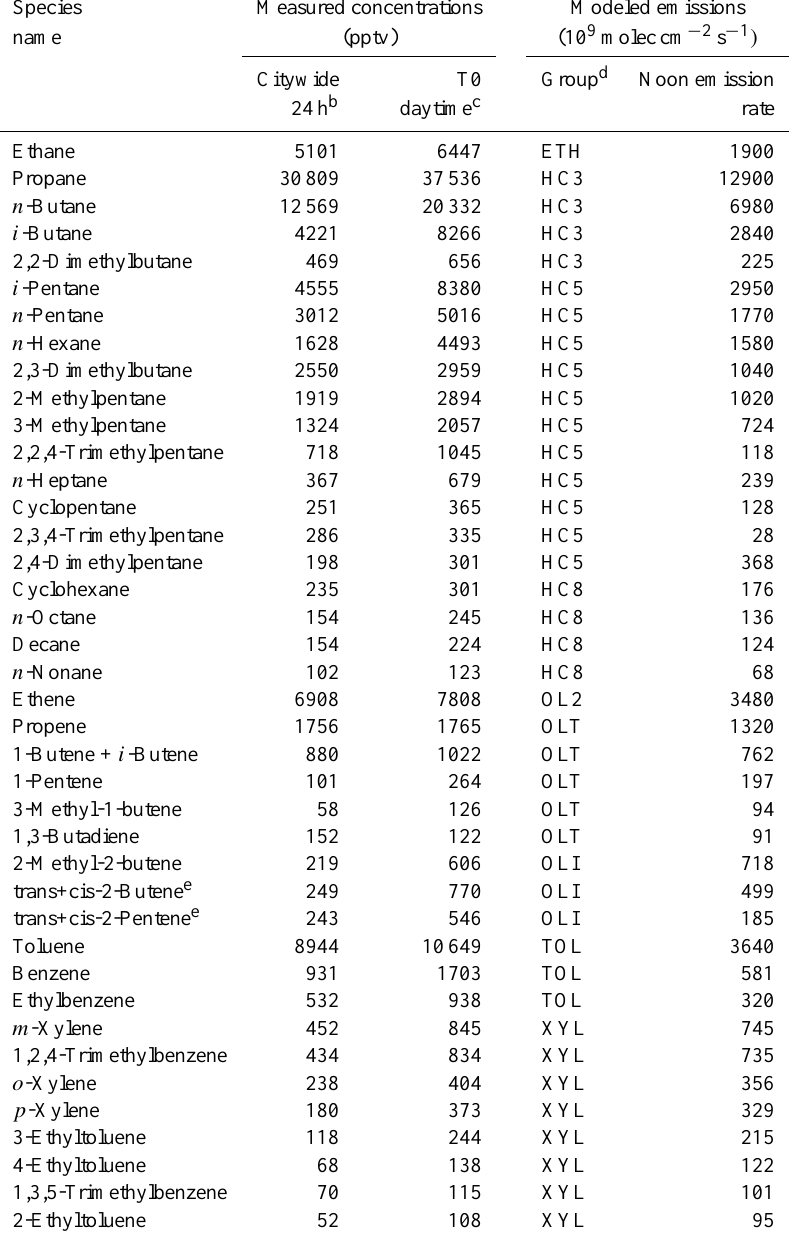
Table 2. NMHCs measured a in Mexico City and included as emissions in the model. Background values for each species were assumed to be